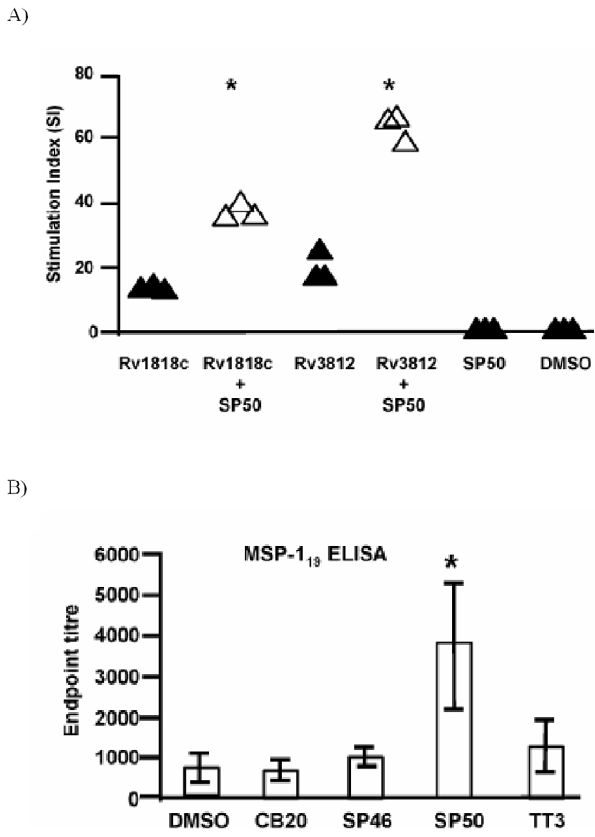
Figure 7. CCR4 antagonists enhance cellular and humoral responses in mice. ( a ) Effect of SP50 on T cell priming to Mycobacterium tuberculosis protein antigens Rv1818c or Rv3812. Splenocytes (0.5 6 10 6 ) from mice immunised with the indicated proteins + SP50 or DMSO were cultured in vitro in the presence of 5 m g/ ml of either Rv1818c or Rv3812 recombinant proteins for 5 days. Cells from three mice per group were tested individually in quadruplicate wells. Antigen-specific T cell proliferation was measured by thymidine incorporationassayanddata arepresented as stimulation index(SI, mean cpm of the antigen stimulated wells/mean cpm of control wells). Significant differences are indicated by asterisks * p , 0.05. The results are from one experiment. ( b ) IgG serum antibody responses against MSP-1 19 measured by ELISA 14 days post vaccination with Ad-MSP-1 42 plus the indicated compounds or DMSO control. Three mice per group were tested individually. Columns represent the mean 6 SD. Significant differences are indicated by asterisks * p , 0.05. Similar results were obtained in two independent experiments. doi:10.1371/journal.pone.0008084.g007 injected mice versus 4–4.5% CD4 + FoxP3 + T cells in control